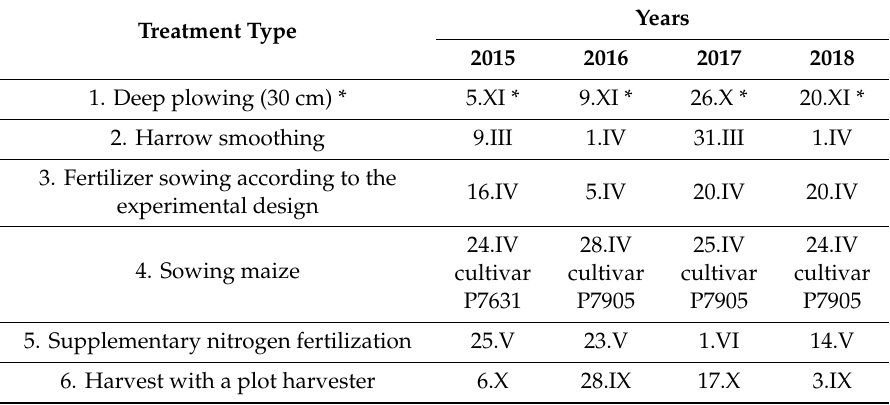
Table 2. Time points (dates) of agrotechnical treatments in